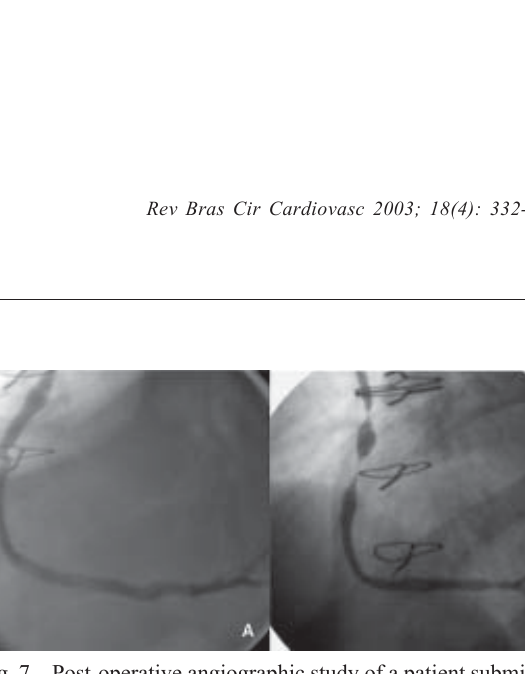
Fig. 7 – Post-operative angiographic study of a patient submitted to an anastomosis saphenous graft to the right coronary artery utilizing a mechanical suture. A. Catheterism performed in the immediate post-operative period demonstrating a patent saphenous vein graft. B. Catheterism performed 13 months after the operation, revealing the saphenous vein graft with serious